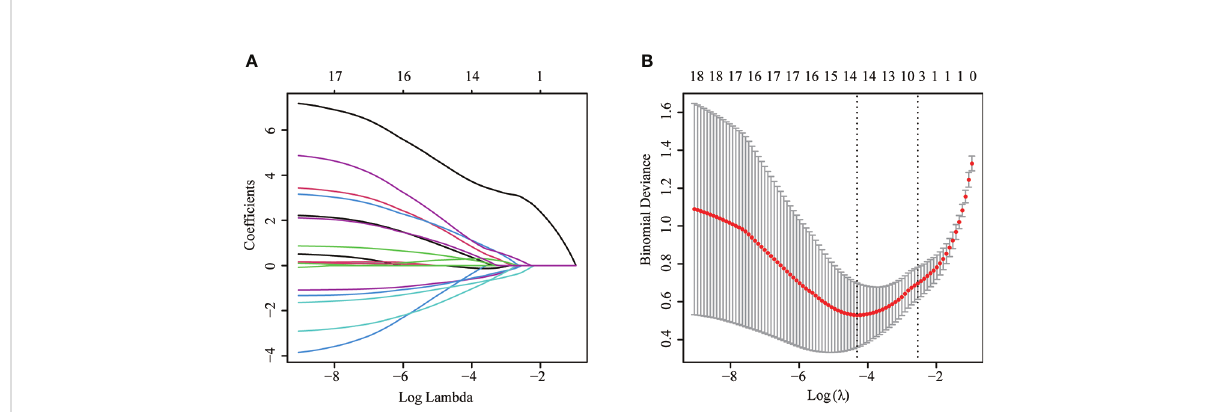
FIGURE 2 The LASSO logistic proportional hazard regression to screen risk factors for MPE. (A) The plot of partial likelihood deviance of LASSO logistic regression. (B) Plot of LASSO coef fi cient pro fi les.